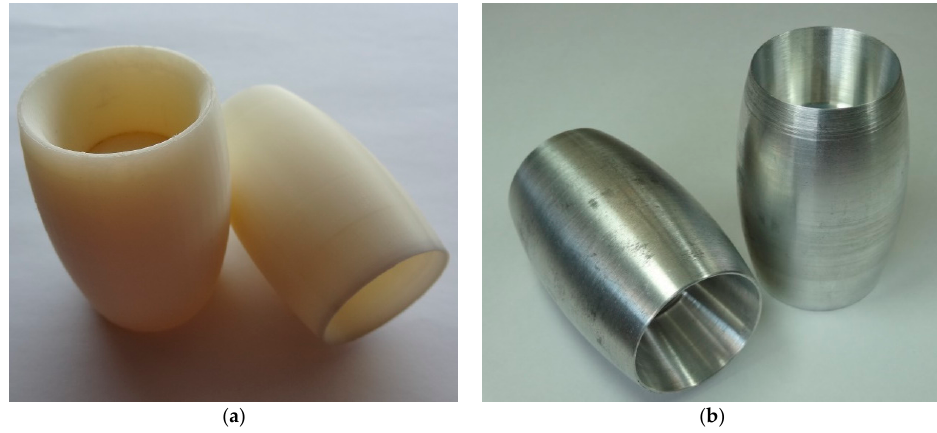
Figure 11. Big passive roller implemented in ( a ) plastic ABS and ( b ) aluminum.